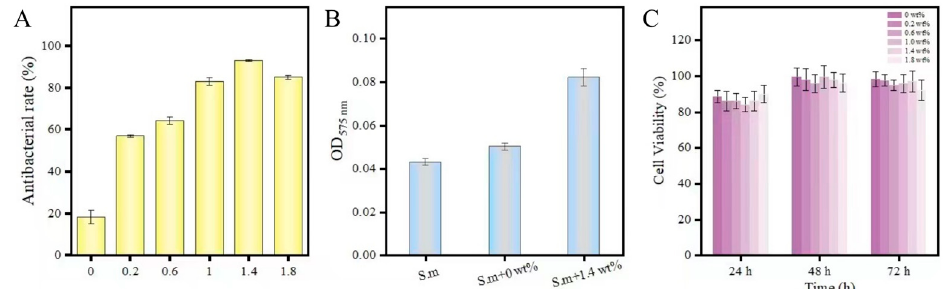
Figure 7. ( A ) Antibacterial rate of hAP (0, 0.2, 0.6, 1.0, 1.4, 1.8 wt%); ( B ) The original bacterial solution, the absorbance of hAP (0 wt%) and hAP (1.4 wt%) at 575 nm; ( C ) Cell viability of L 929 cells co-cultured with hAP (0, 0.2, 0.6, 1.0, 1.4, 1.8 wt%) .